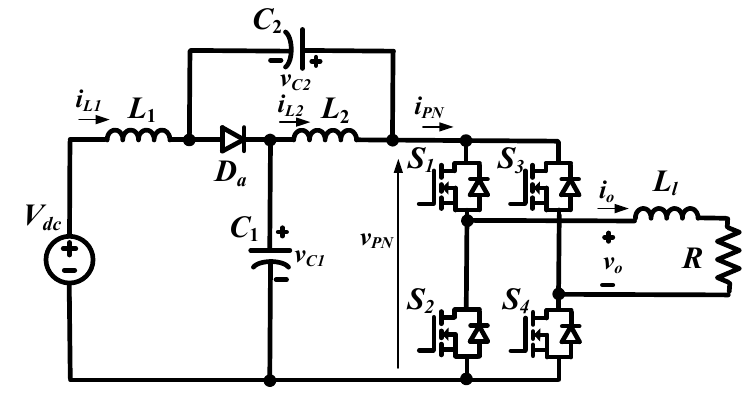
Figure 1. Single-phase quasi-Z-source inverter.